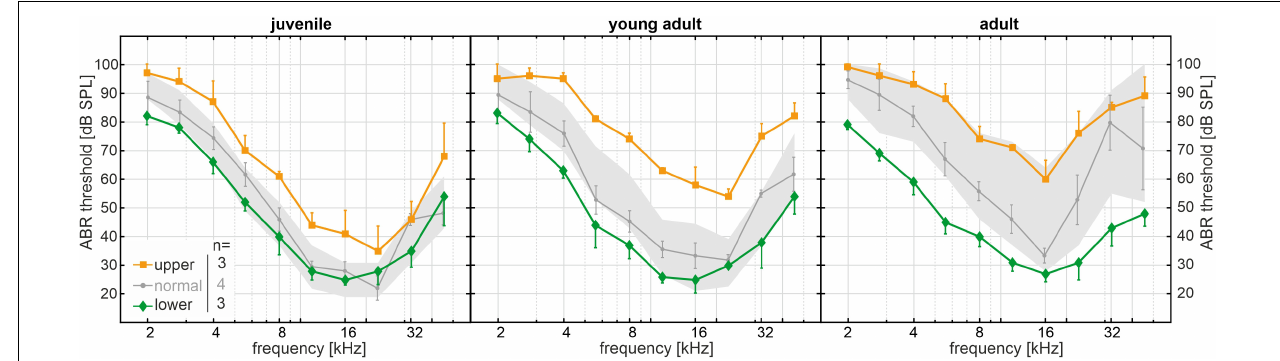
FIGURE 3 | Long-term SAMP8 monitoring cohort ( n = 10) with auditory brainstem response (ABR) thresholds measured at juvenile (34 days), young adult (80 days), and adult age (195 days). ABR thresholds were compared with the interquartile range of the reference cohort for each age group (gray area, see Figure 2 ) and divided into subgroups in the lower quartile (green diamonds, n = 3), in the normal range (gray circles, n = 4), and in the upper quartile (orange squares, n = 3) based on their progression of age-related threshold increase over age. For each age group and subgroup, mean and standard error of the mean ABR thresholds are shown.